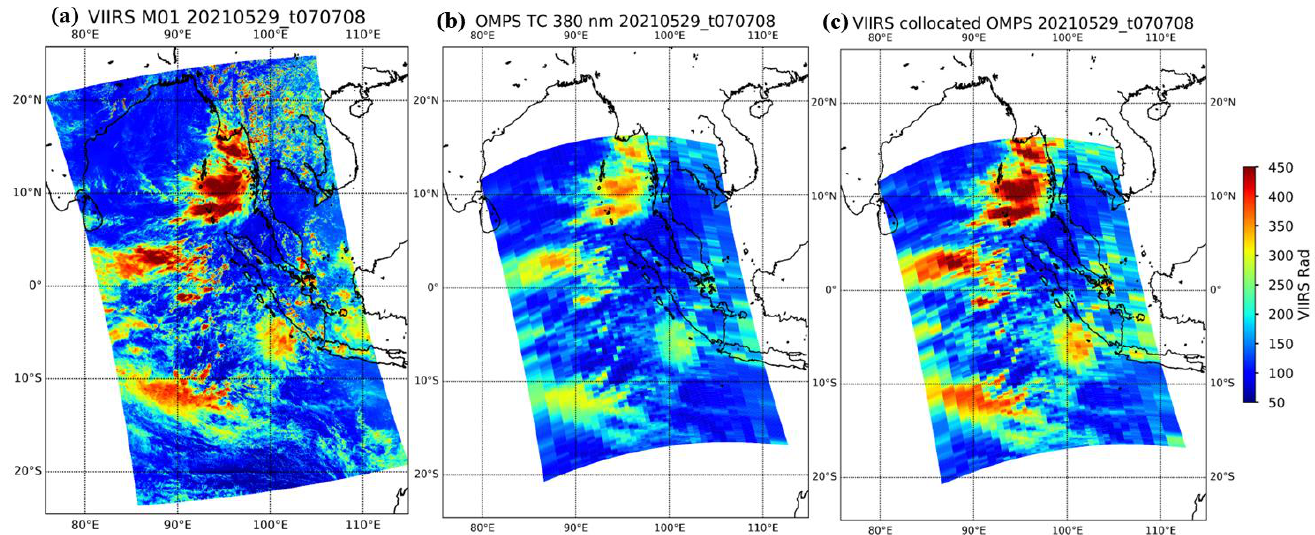
Figure 1. ( a ) VIIRS image at the M01 band (412 nm) on 29 May 2021; ( b ) the correspondent OMPS-NM image at 380 nm; ( c ) VIIRS-collocated image based on the OMPS-NM geometry characteristics. The radiance unit is W/(cm 3 Sr) in the images.